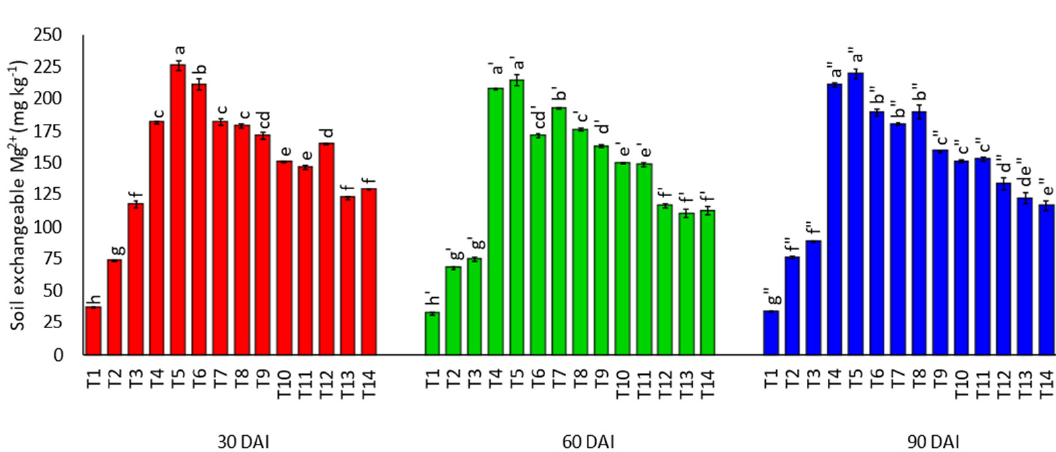
Figure 11. Effects of treatments on soil exchangeable magnesium ions after thirty, sixty, and ninety days of incubation, where T1: soil alone, T2: Egypt rock phosphate alone, T3: Egypt rock phosphate + 100% charcoal, T4: Egypt rock phosphate + 100% sago bark ash, and T5: Egypt rock phosphate + 100% charcoal + 100% sago bark ash, T6: Egypt rock phosphate + 75% charcoal + 75% sago bark ash, T7: Egypt rock phosphate + 50% charcoal + 75% sago bark ash, T8: Egypt rock phosphate + 25% charcoal + 75% sago bark ash, T9: Egypt rock phosphate + 75% charcoal + 50% sago bark ash, T10: Egypt rock phosphate + 50% charcoal + 50% sago bark ash, T11: Egypt rock phosphate + 25% charcoal + 50% sago bark ash, T12: Egypt rock phosphate + 75% charcoal + 25% sago bark ash, T13: Egypt rock phosphate + 50% charcoal + 25% sago bark ash, and T14: Egypt rock phosphate + 25% charcoal + 25% sago bark ash. Means with different letter(s) within the same incubation period indicate significant differences between treatments according to Tukey’s HSD test at p ≤ 0.05, i.e., a > b > c. Bars represent the mean values ± SE.